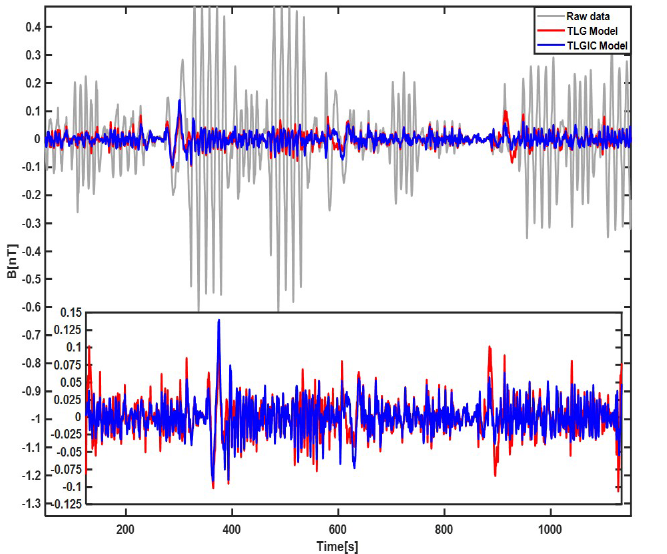
Figure 2. Compensation results of the first–lap flight data using the TLG model and TLGIC model.